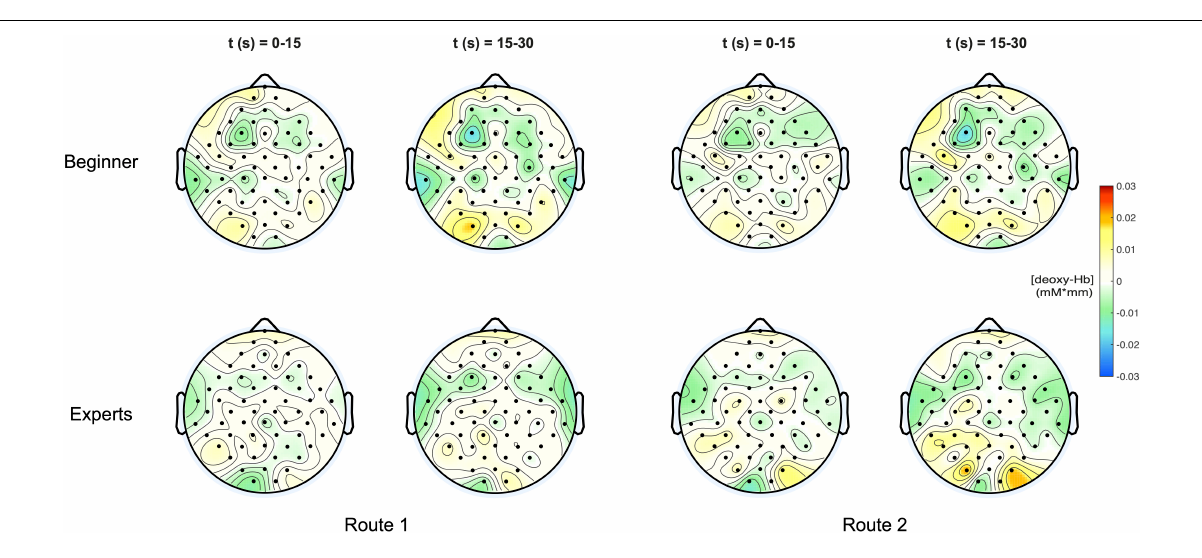
averaged concentration values are plotted at their corresponding spatial positions (Pfurtscheller et al.,